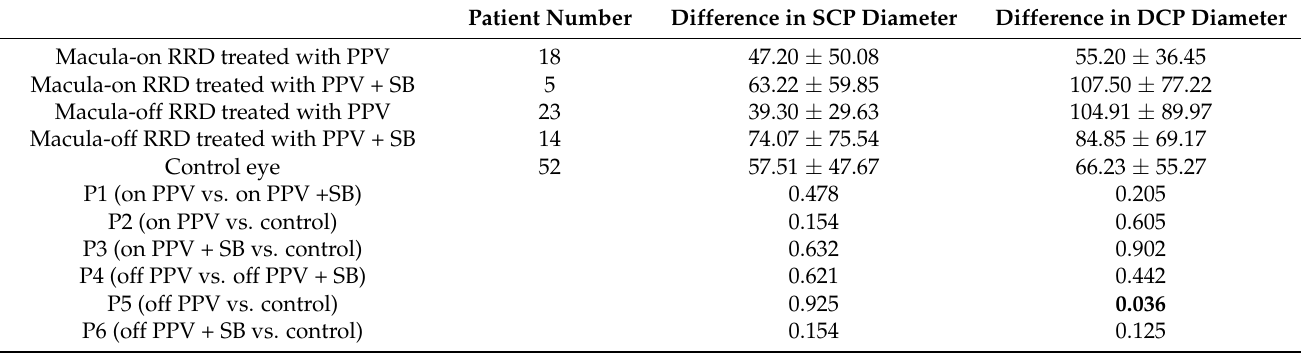
Table 4. Differences of diameters of the FAZ area (in mm 2 ) in both the SCP and DCP vs. control eyes depending on the prior macular status and the surgical procedure. Bold values are statistically significant ( p < 0.05) (Mann–Whitney U test for non-parametric values).